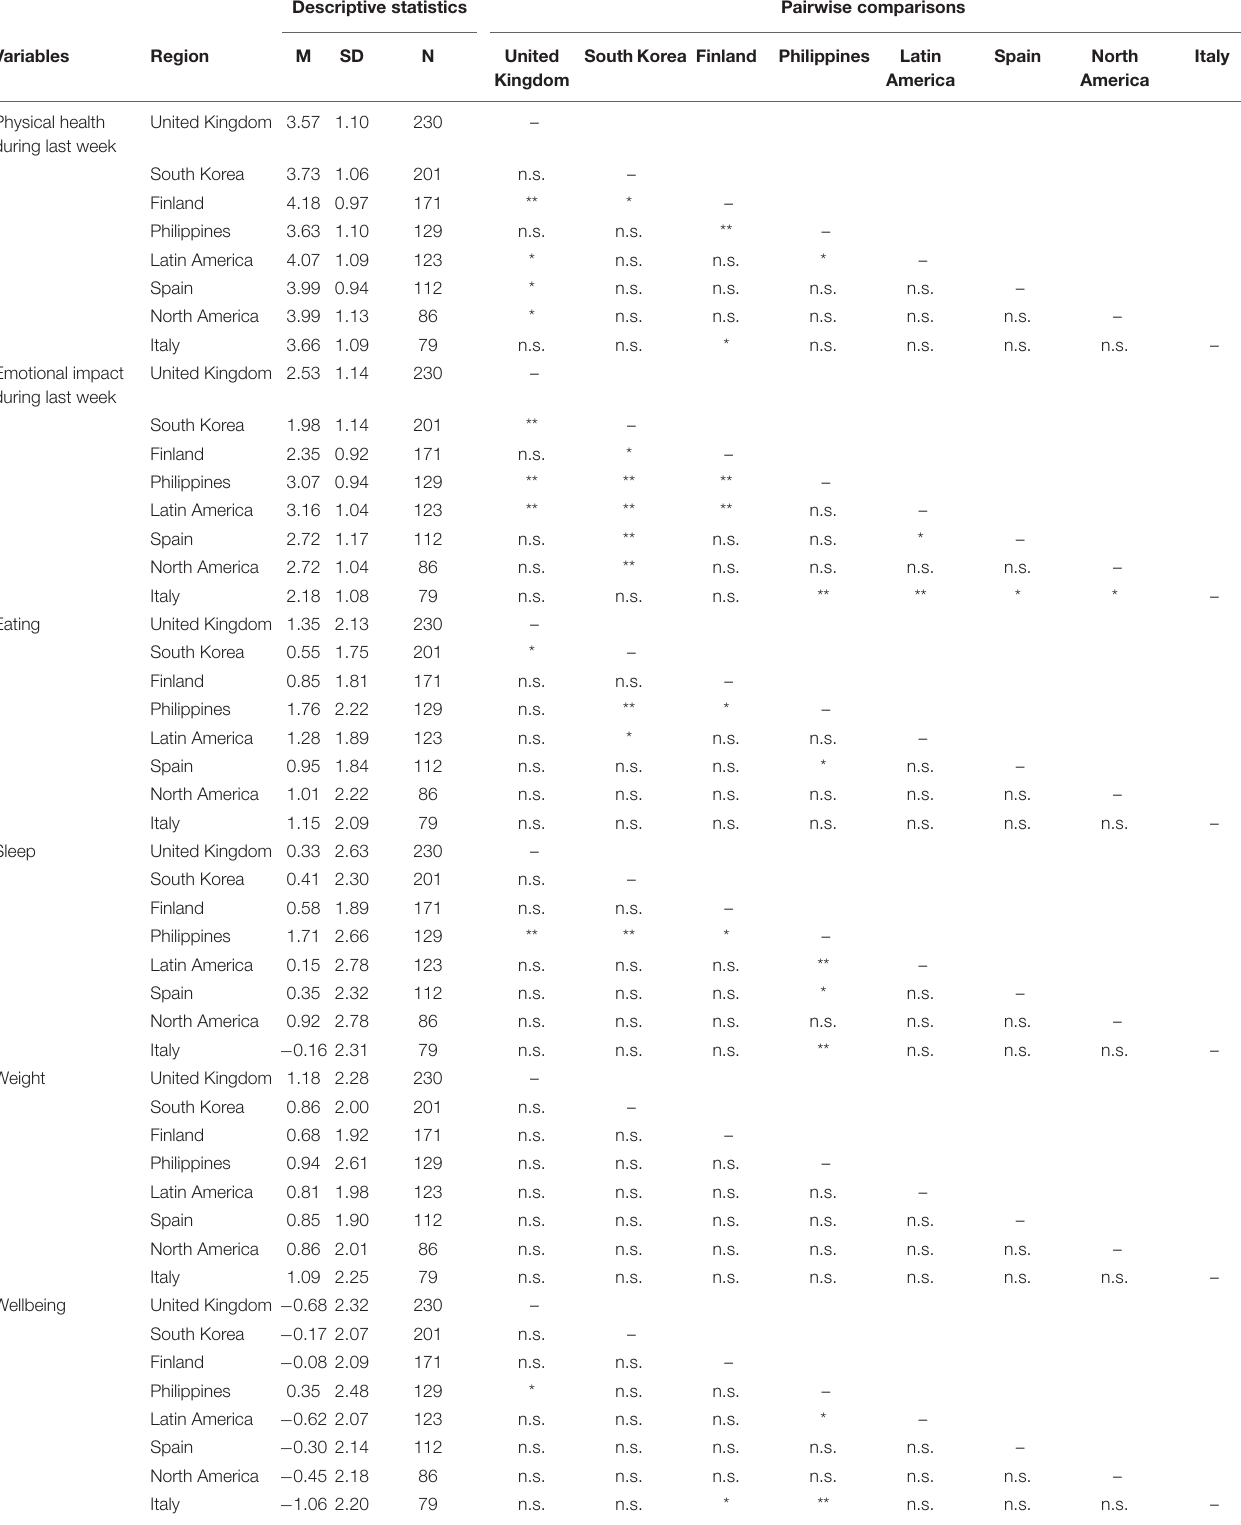
TABLE 2 | Descriptive statistics and pairwise comparisons across